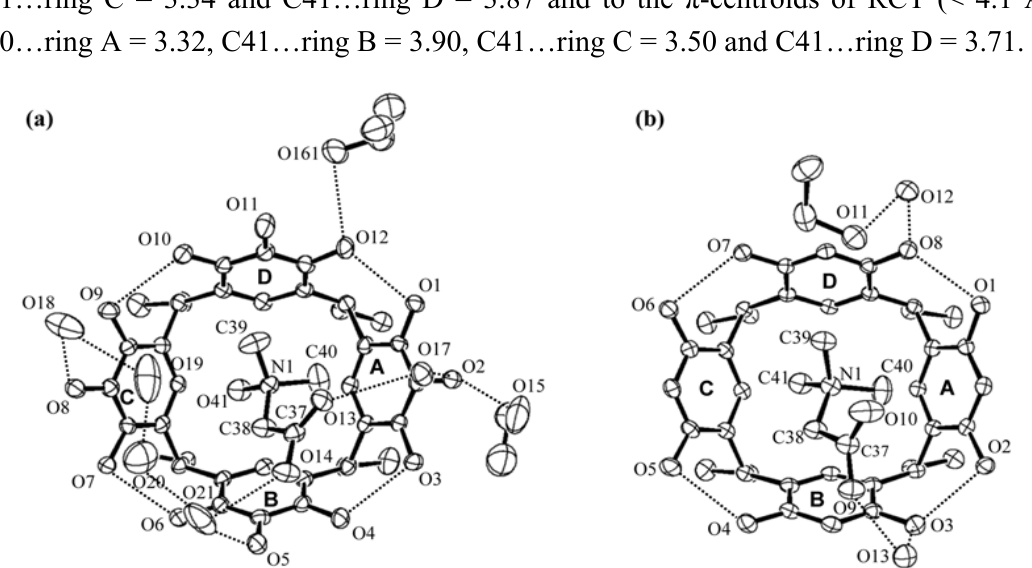
Figure 1. The structures of betaine complexes with pyrogallol cyclic tetramer (PCT) (a) and resorcinol cyclic tetramer (RCT); (b) determined by X-ray crystallography are described with ORTEP. Dotted lines represent conventional hydrogen bonds. The names of all oxygen atoms and atoms of the betaine molecule are indicated to distinguish the